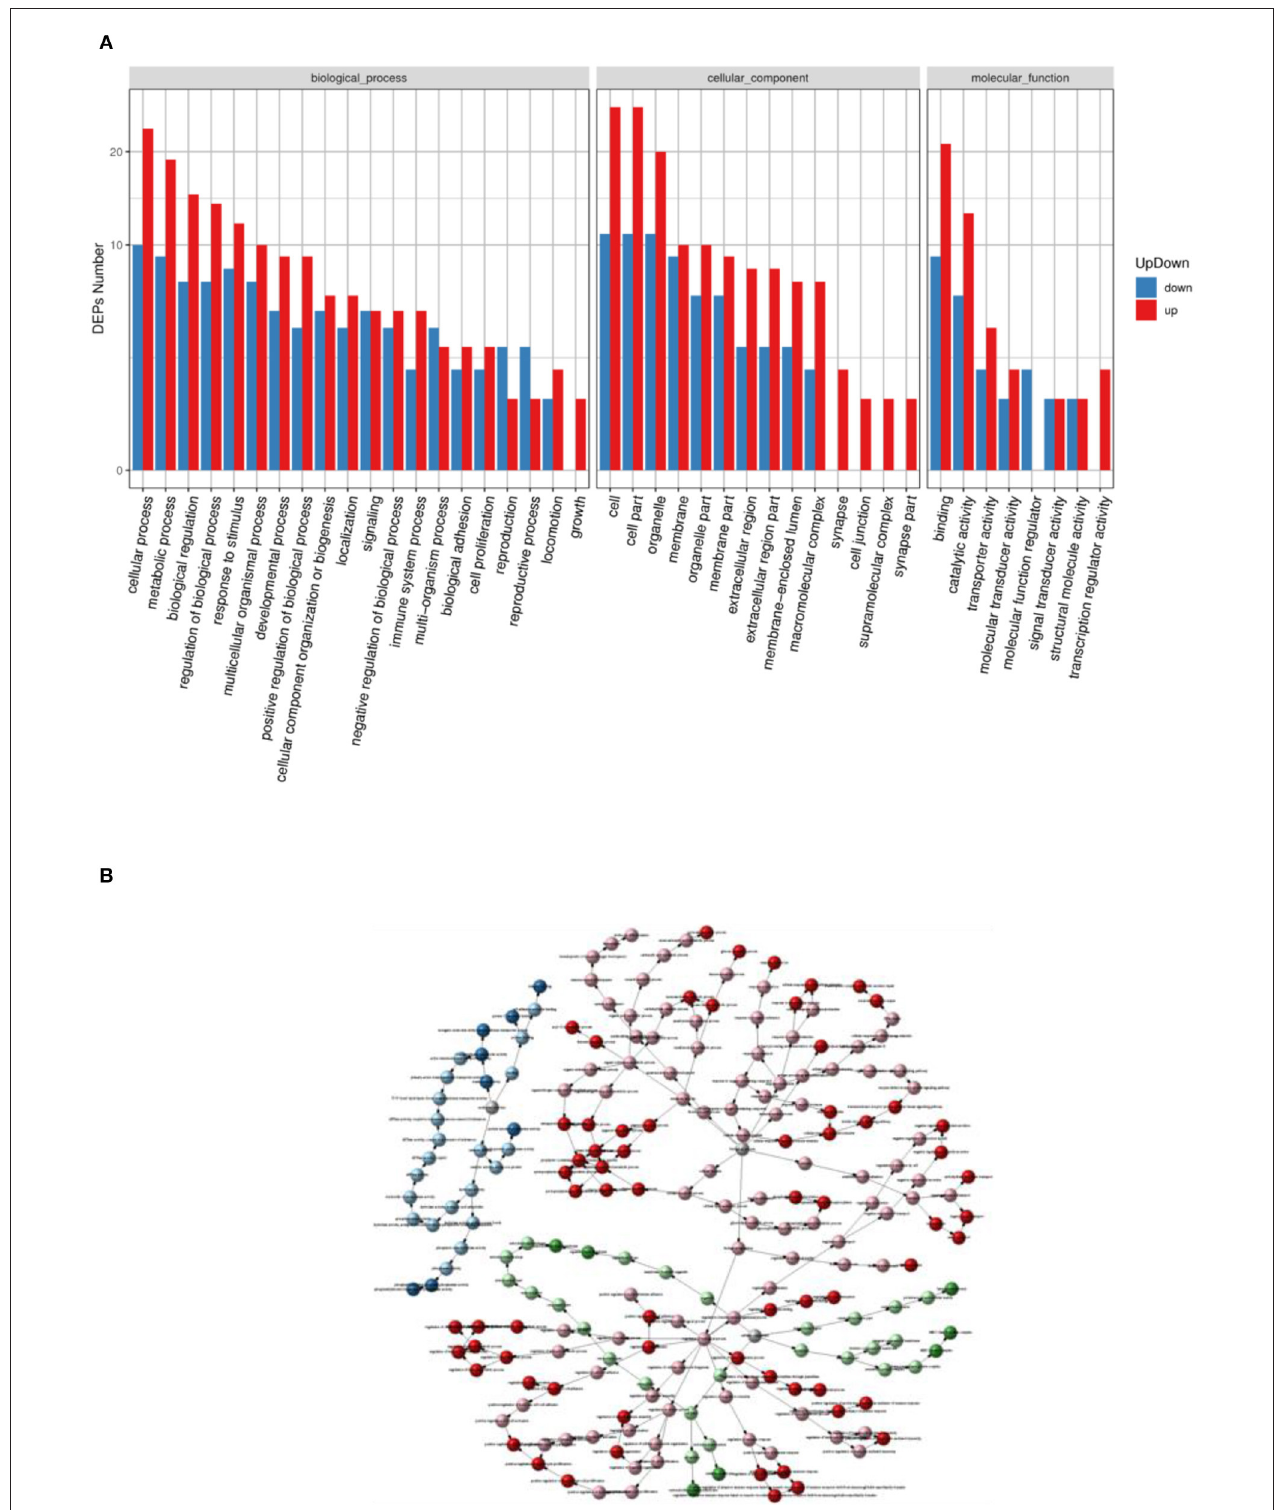
FIGURE 5 | Statistical graph of up- and down-regulation of GO functional classification of differential proteins in HD and MC groups (A) and GOterm relationship network graph (B) .